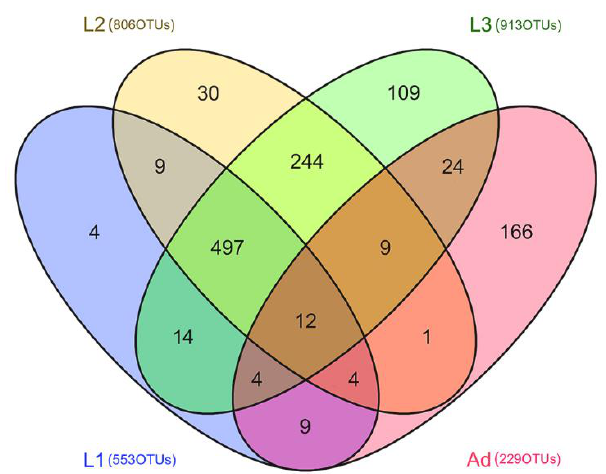
Figure 1. Venn diagram showing the co-occurence of the OTUs among samples from different stages. Numbers in parentheses indicate total OTUs in each stage group, and numbers inside the Venn diagram indicate unique and shared OTUs. OTU, operational taxonomic unit.